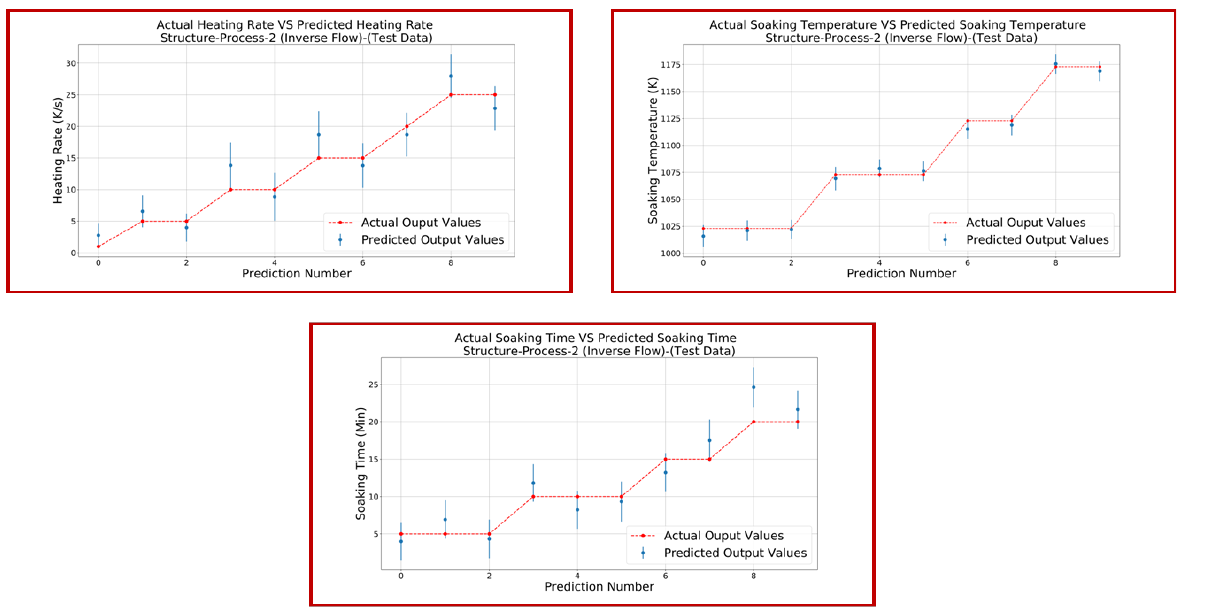
Figure 14. Predicted Output and Actual Output Comparison for Step 3.2 (for Test Dataset).